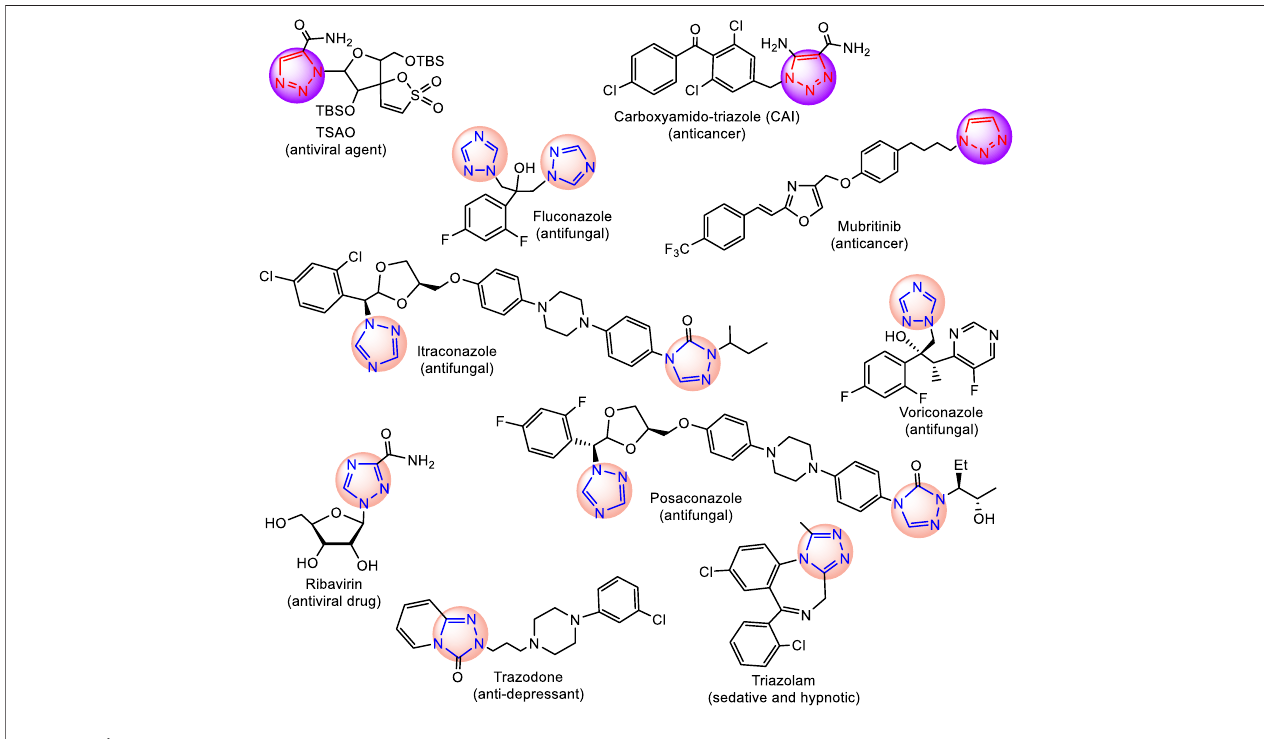
FIGURE 1 | Medicinal drugs with triazole